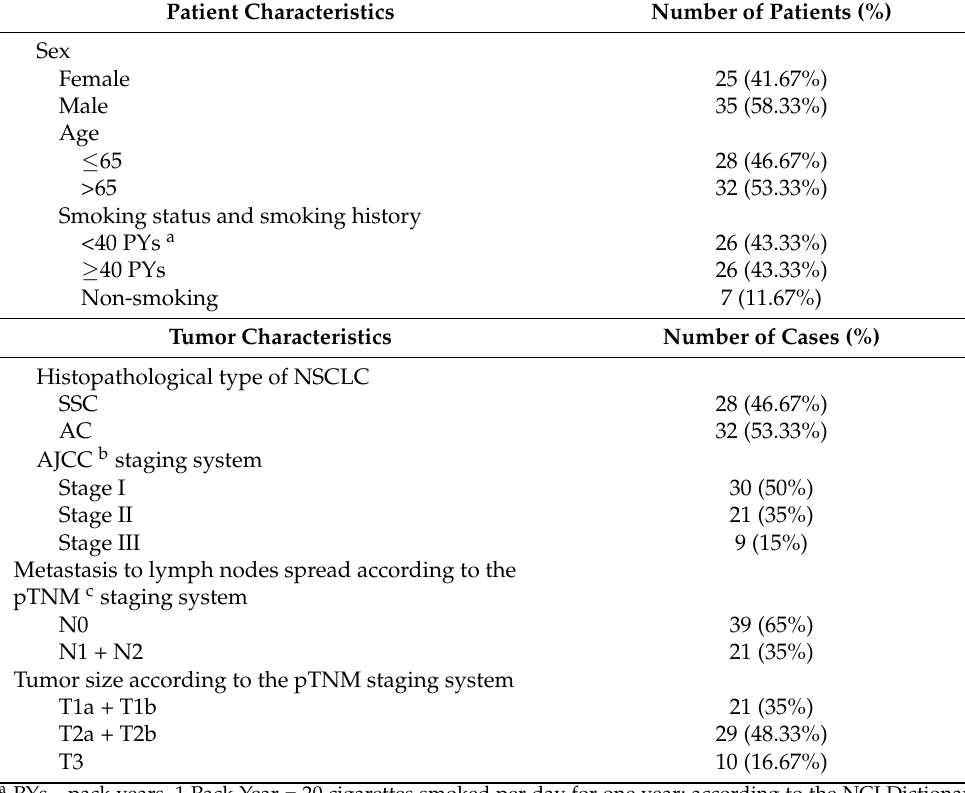
Table 1. Demographic characteristics of patients and features of lung